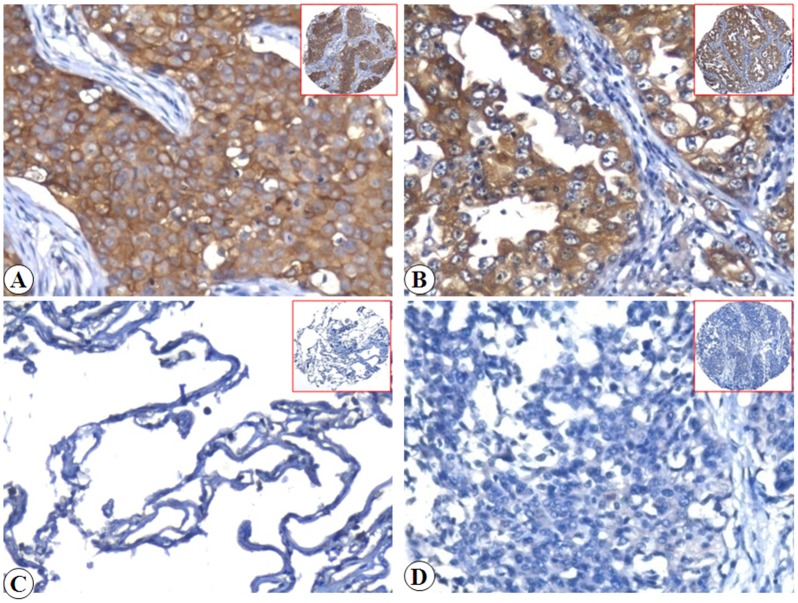
Expression of EGFR protein in lung SCC cells, lung ADC cells and the control of non-cancerous lung tissue were detected by IHC using specific antibody as described in the section of materials and methods.Strong positive staining of EGFR protein was found in cell membranes and cytoplasm of lung SCC and lung ADC cells (Fig 2A and 2B, 20×, IHC, DAB staining). Negative staining of EGFR was showed in non-cancerous lung tissue (Fig 2C, 20×, IHC, DAB staining). Negative control showed no EGFR staining in the lung SCC cells (Fig 2D, 20×, IHC, DAB staining).